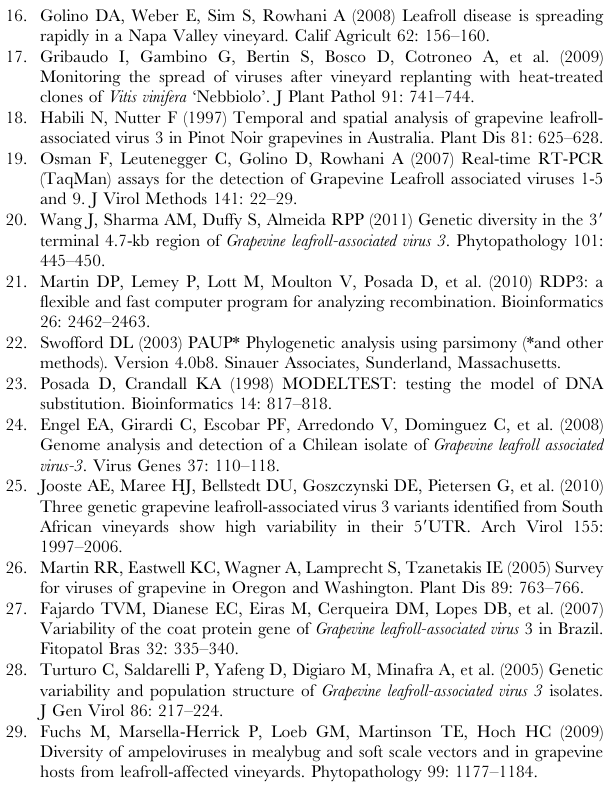
Table S3 Primer sets and multiplex conditions for detection of Grapevine leafroll-associated virus-3 at the variant level. Primer sets for the four variants diagnosed and the conserved coat protein gene (CP) primers were designed in this study but were based on work by Wang et al. (2011, Table S4 Primers used for sequencing of 428 bp of the coat protein gene of Grapevine leafroll-associated virus- 3